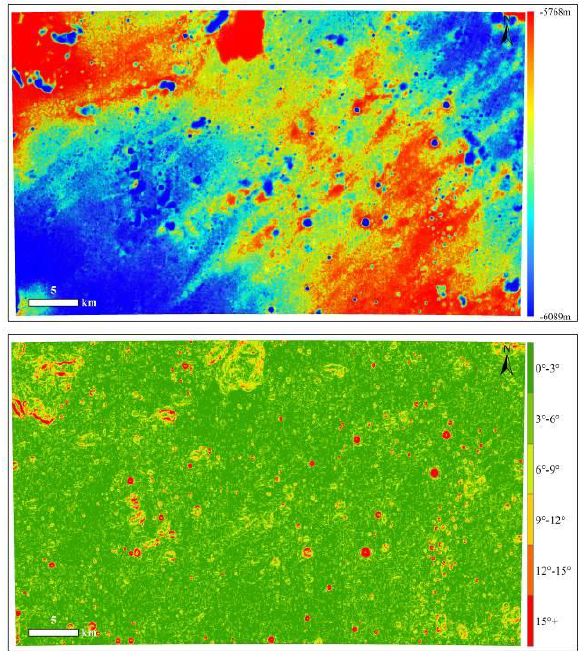
Figure 3. DEM (top) and slope map (bottom) of CE-4 landing site region in Lambert conformal conic projection.